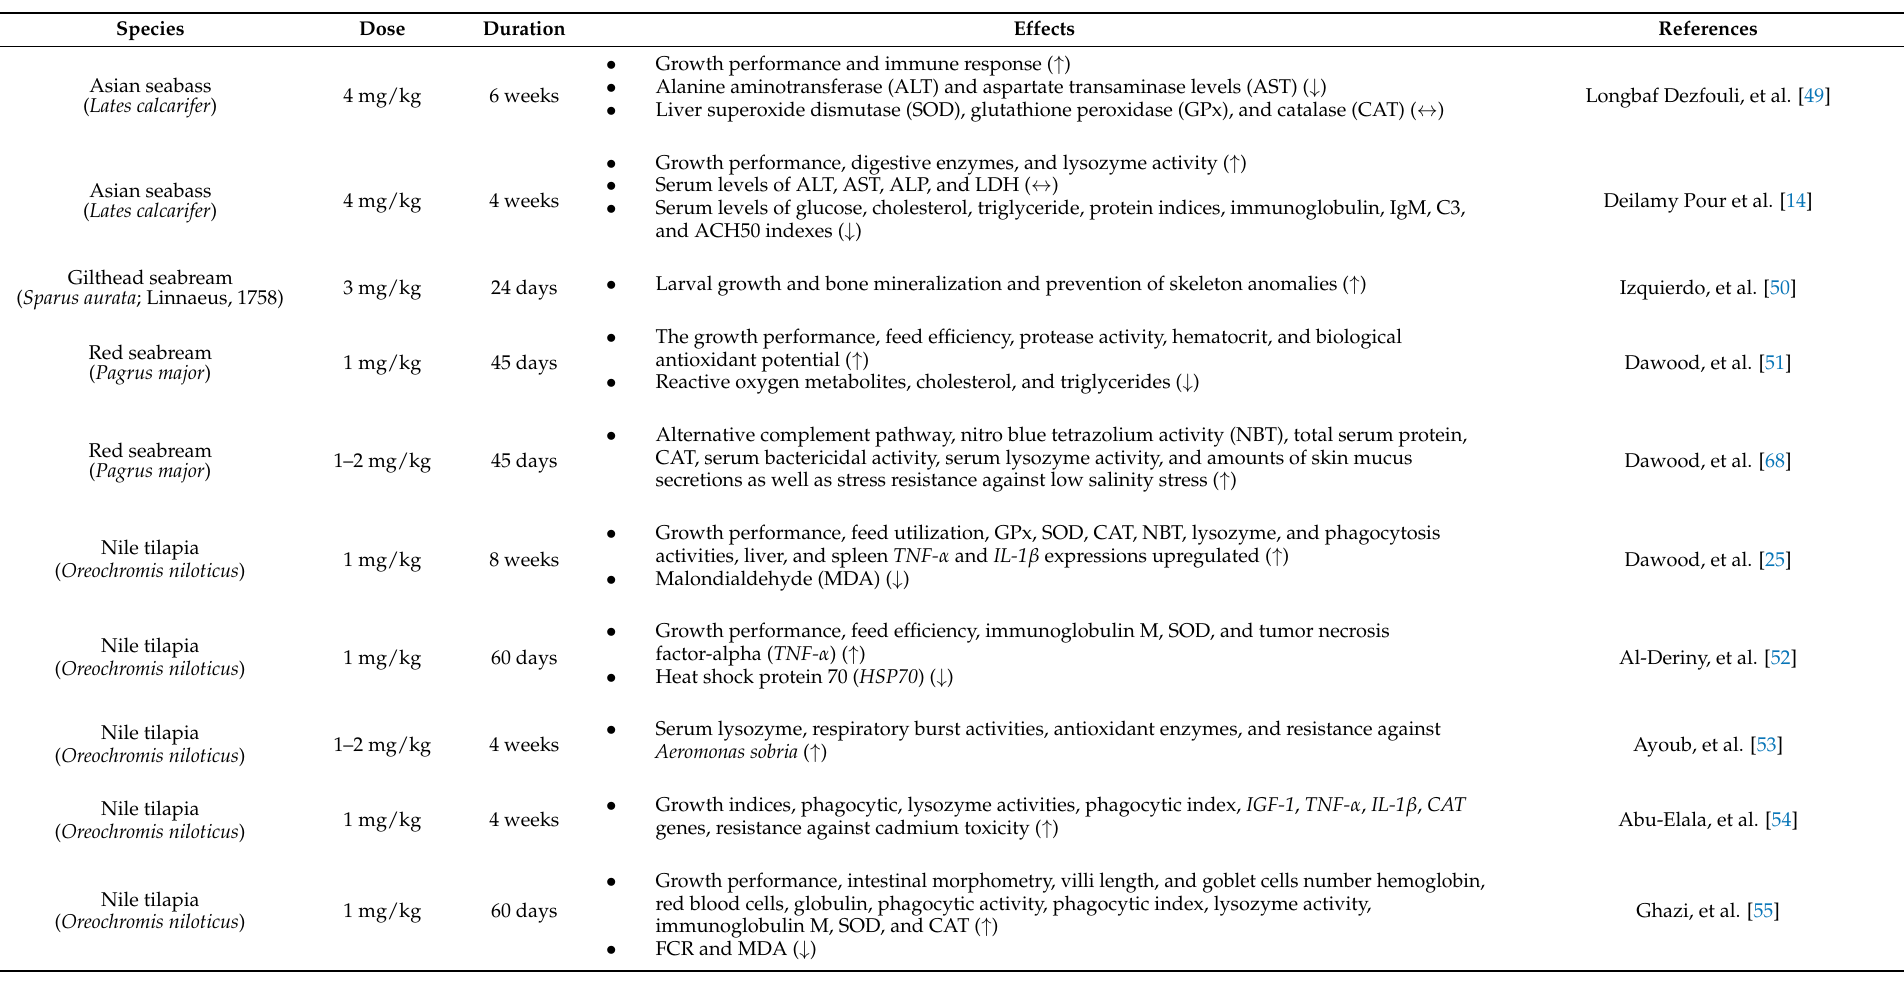
Table 1. The effects of selenium nanoparticles on the performances of aquatic